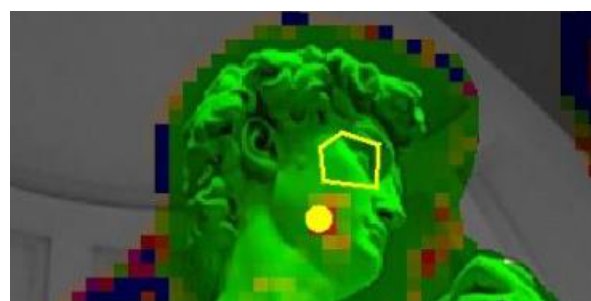
Figure 8 - Reference area on the statue head for deformation analysis: Yellow outlined area on the right David’s chick.